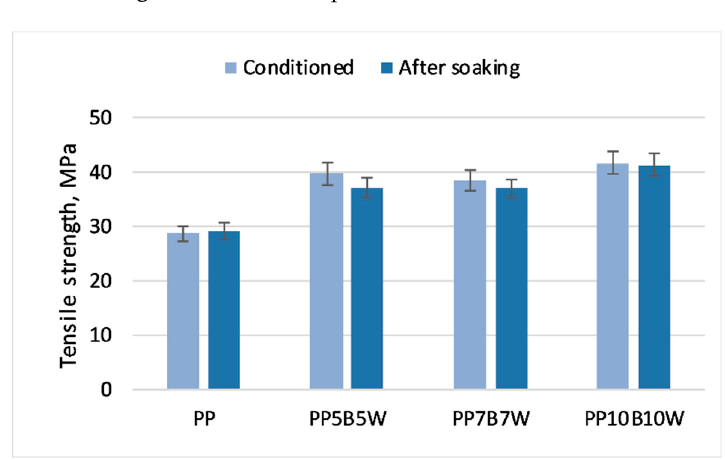
Figure 7. Water absorption of the tested materials.